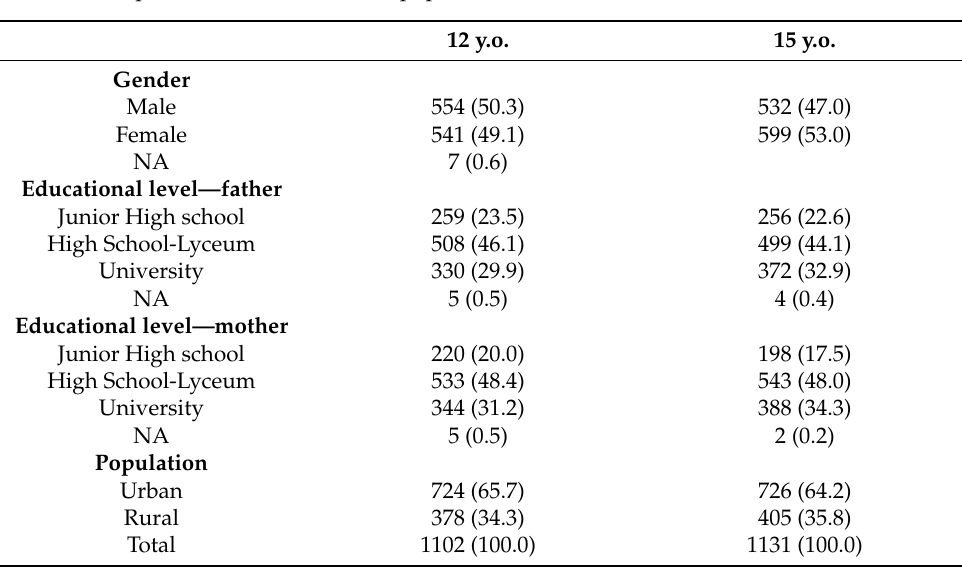
Table 3. Descriptive characteristics of the population.